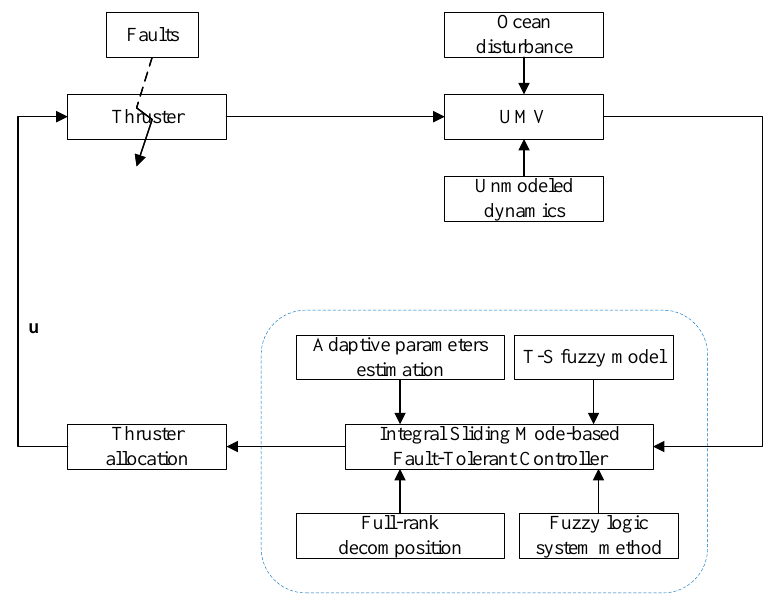
Figure 2. Integral sliding mode fault-tolerant strategy for T-S model of UMV with